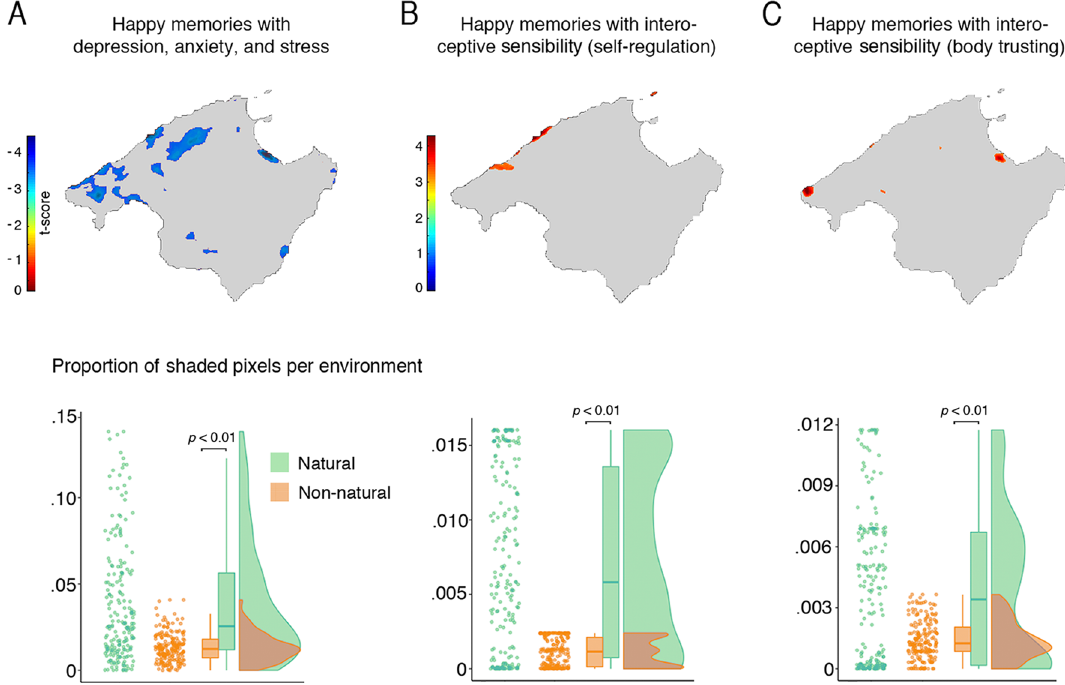
Figure 4. Spatial maps of emotional memories correlate with affect and interoceptive sensibility. SPM analyses of the subject-wise maps showed that spatial maps of emotional memories correlated with participants’ scores in the Dass21 and two subscales of the MAIA questionnaire. ( A ) Areas where participants with lower scores in depression, anxiety, and stress (Dass21) reported having happier memories (uncorr. at 0.01). In these clusters, the number of pixels in natural environments was greater than in non-natural (lower panel, p < 0.001). ( B , C ) Areas where participants with greater interoceptive sensibility (self-regulation and Body trusting subscales) reported having happier memories (uncorr. at 0.01). In all these SPM clusters, the number of pixels in natural environments was greater than in non-natural ( p < 0.001); n = 201; colorbars denote the t-statistic range; comparisons between environments computed via Wilcoxon statistical test. Outline maps are under Creative Commons license CC0 from